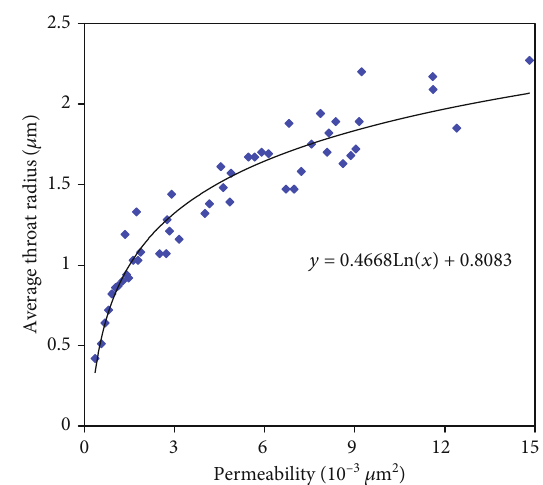
Figure 4: Relationship between permeability and average throat